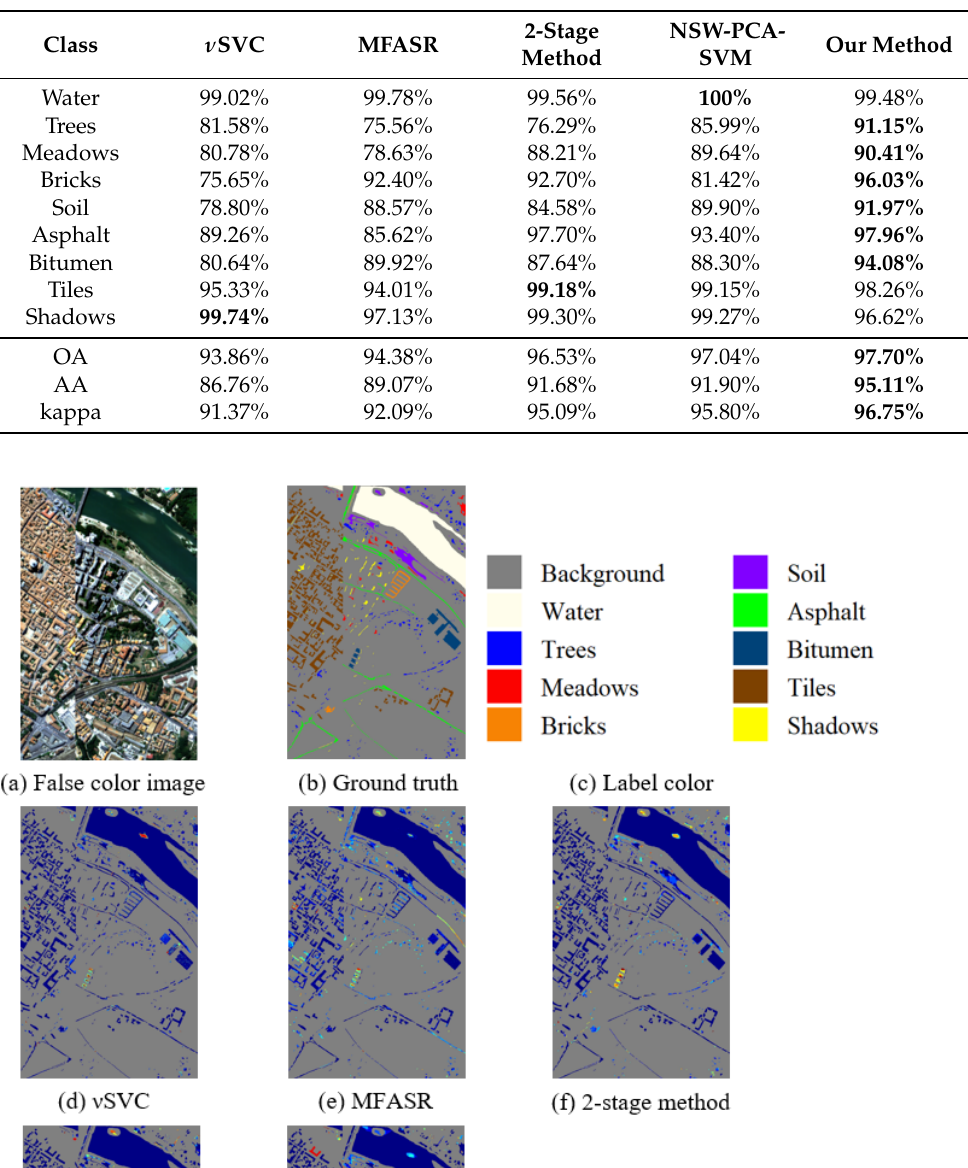
Table 3. Average classification accuracies over 10 trials for the Pavia Center dataset with 10 random training pixels for each class. The boldface font represents the highest accuracy among the methods.